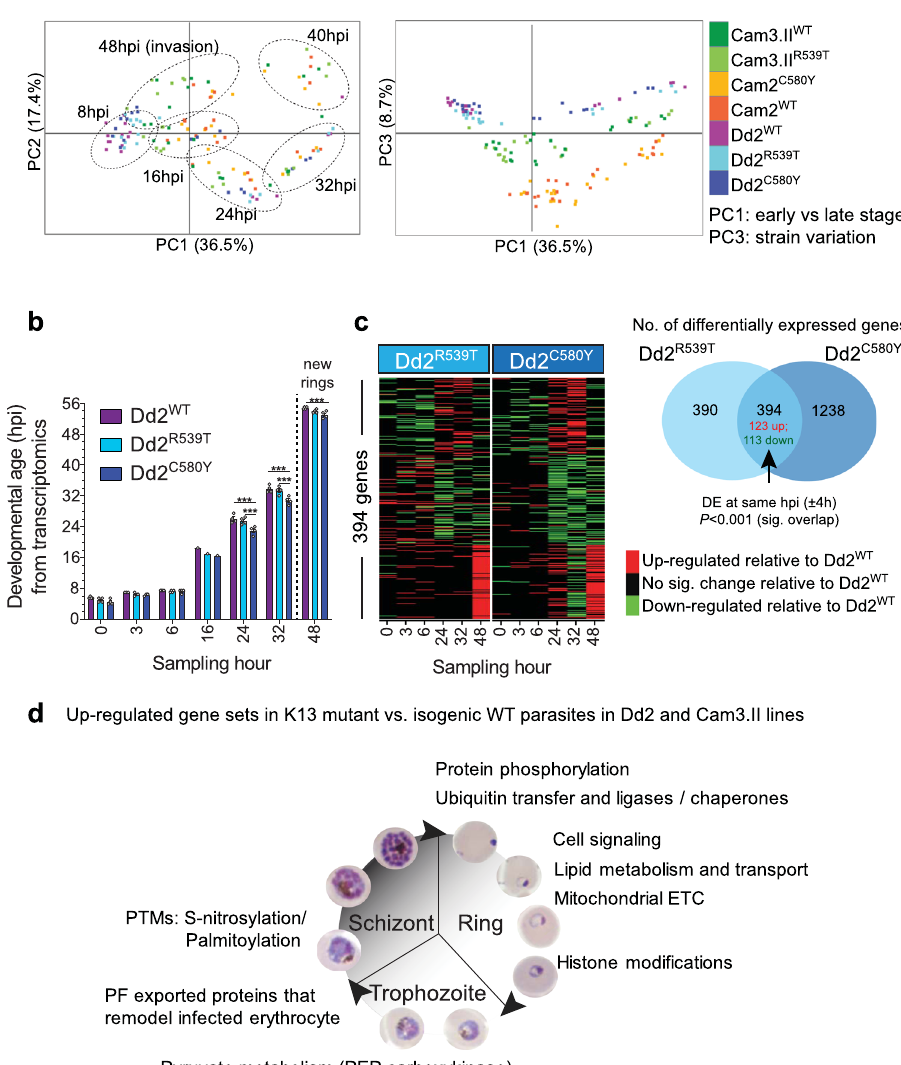
Fig. 2 K13 mutations associate with altered temporal cell-cycle progression and broad transcriptional changes throughout the 48 h IDC. a PCA plots for transcriptome samples labeled by parasite line, K13 status, sampling time, and parasite asexual stage. This analysis was conducted on Cam3.II and Dd2 K13 WT, C580Y and R539T samples, as well as the Cam2 isogenic K13 C580Y and WT pair 16 . b Transcriptomics-based age estimation for R539T and C580Y mutants and isogenic WT Dd2 parasites determined by comparison against a Dd2 reference 48 h IDC 68 . Dd2 C580Y mutant parasites showed a signi fi cant albeit modest (up to 4 h) slowing of the developmental cycle during the 16 – 48 h developmental period, relative to Dd2 WT and Dd2 R539T parasites. Each time point was harvested on three independent occasions (data points are presented as means ± SEM), except for the 16 h time point that was collected only once. Differences between lines were examined using a two-sided t -test; *** P < 0.001. P values for each comparison were 24 h time point – Dd2 C580Y vs. Dd2 WT P = 1.7E − 6, Dd2 C580Y vs. Dd2 R539T P = 5.1E − 5; 32 h time point – Dd2 C580Y vs. Dd2 WT P = 1.7E − 6, Dd2 C580Y vs. Dd2 R539T P = 2.6E − 5; 48 h time point – Dd2 C580Y vs. Dd2 WT P = 0.002. c Venn diagram (right) showing signi fi cant overlap of 394 DE genes in pair-wise comparisons between the gene-edited K13 mutant and WT lines at the same developmental stage (± 4 h). Heat map of k means-clustered overlapping DE genes in each pair-wise comparison, showing a similar pro fi le of differential expression in both the R539T and C580Y mutants as compared to the WT line. Signi fi cant changes in expression levels were de fi ned using a two-sided t -test ( P < 0.05). Results also revealed consistent up-regulation of 80 genes in the 48 h late segmenter/early ring-stage samples of both K13 mutant parasite lines (see lower rows; detailed in Supplementary Data 1). The Venn diagram analysis used a binomial distribution test, with P = 5.7E − 32. d Signi fi cantly up-regulated gene sets common to both K13 mutants relative to WT parasites (hypergeometric testing, P < 0.05) across the 48 h cycle in both the Cam3.II and Dd2 backgrounds (see Supplementary Data 2). ETC electron transport chain, hpi hours post invasion, PEP phosphoenolpyruvate, PTMs post-translational modi fi (Supplementary Fig. 5a and Supplementary Data 4). Sample-to- Fig. 5b). Metabolomic set enrichment analyses of untreated ring- sample correlation of the metabolite expression pro fi les showed stage parasites revealed that the C580Y mutation affected the that ring-stage samples clustered separately from trophozoites basal levels of metabolites involved in the TCA cycle, as well as and uninfected RBC controls, indicating substantial changes in purine, glutamate, and pyruvate metabolism (Fig. 3c). Partial parasite metabolism throughout the IDC (Supplementary least-squares discriminant analyses revealed several metabolites